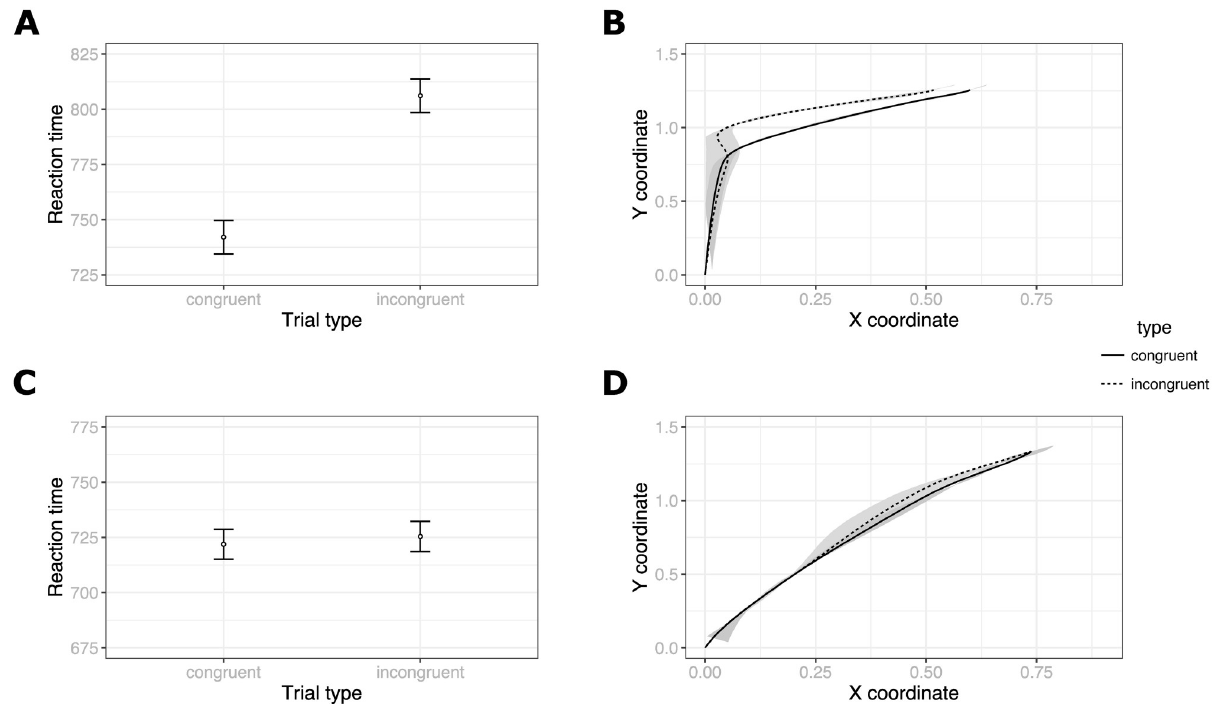
Fig 3. Results of Experiment 1 (A and B) and 2 (C and D). Reaction times with 95% confidence intervals are shown in figures A and C. Figures B and D show normalized movement trajectories averaged across participants with shaded areas corresponding to a 95% confidence interval on each